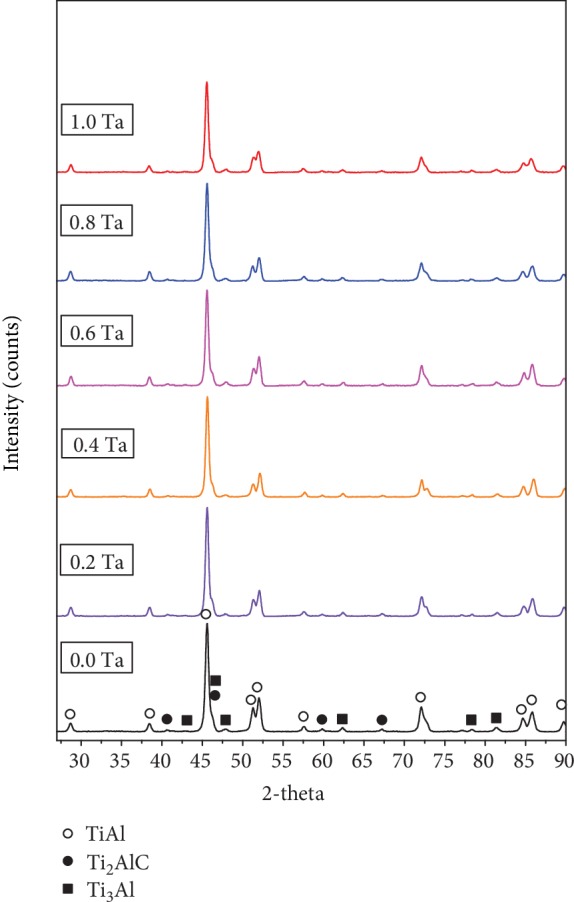
Results of XRD in the Ti46Al8Nb2.6CxTa alloys.